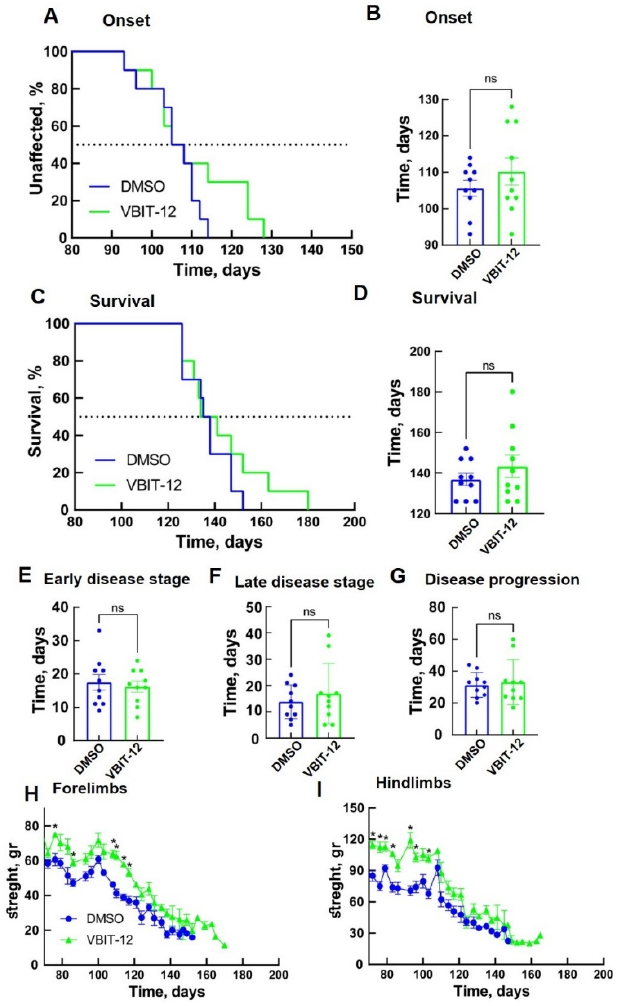
Figure 5. VBIT-12 administration by IP injection improved muscle endurance of SOD1 G93A mice but did not significantly extend disease onset and survival. Mean age of disease onset, defined